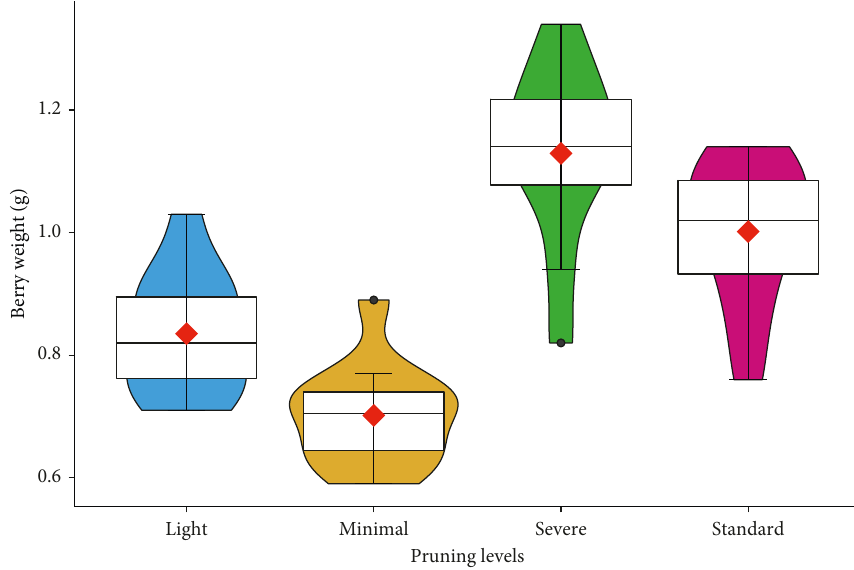
Figure 2: Effect of pruning level in grapevine berry weight.